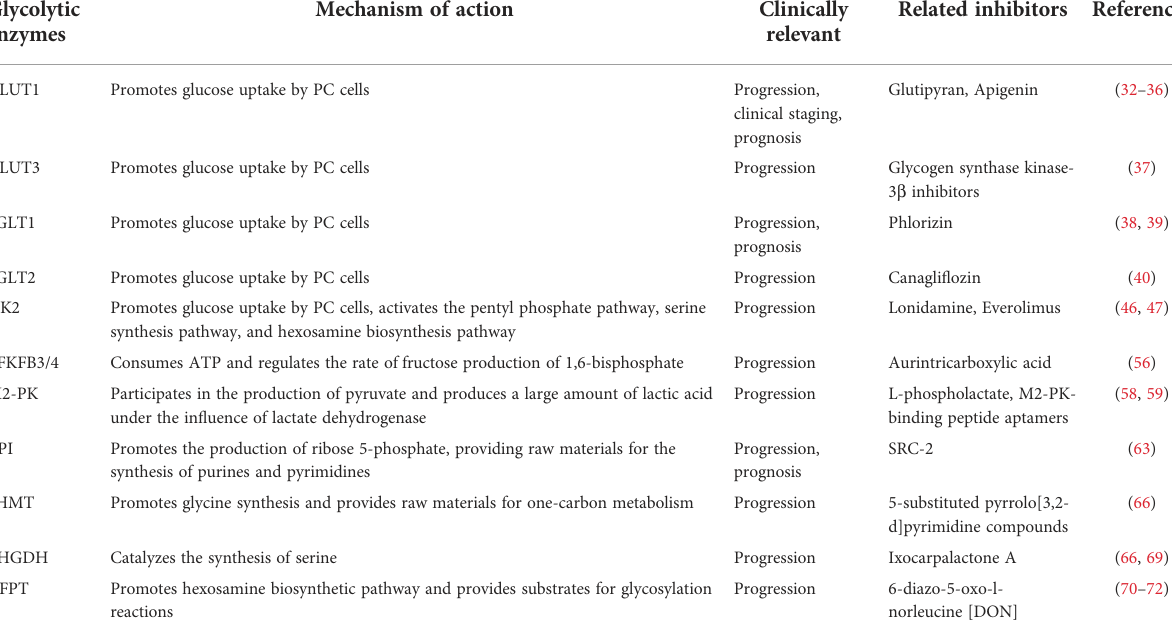
TABLE 1 Summary of the mechanism and clinical relevance of key glycolytic enzymes in the progression of PC. Glycolytic